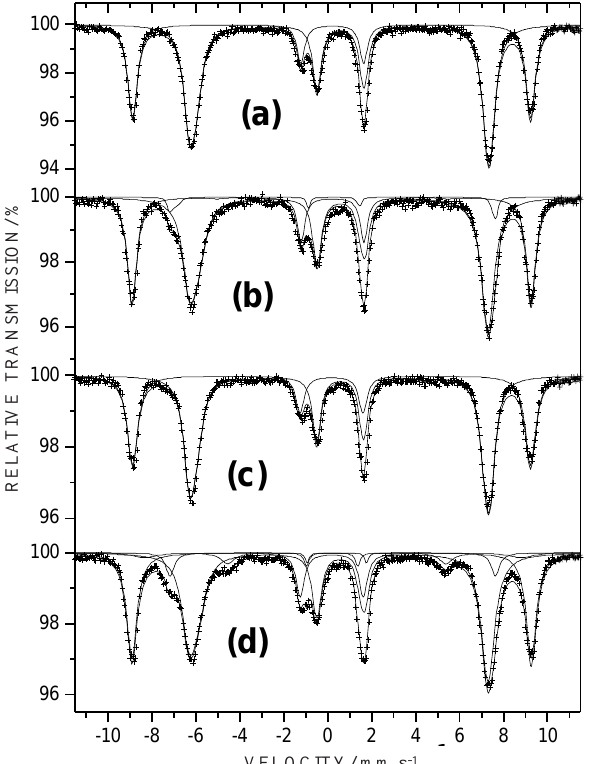
Figure 4. 160 K Mössbauer spectra obtained with an externally applied magnetic field of 6 tesla. (a) Untreated magnetic extract of the fresh rock and treated 7xCBD magnetic extracts from (b) altered rock; (c) soil-sand and (d) soil-silt